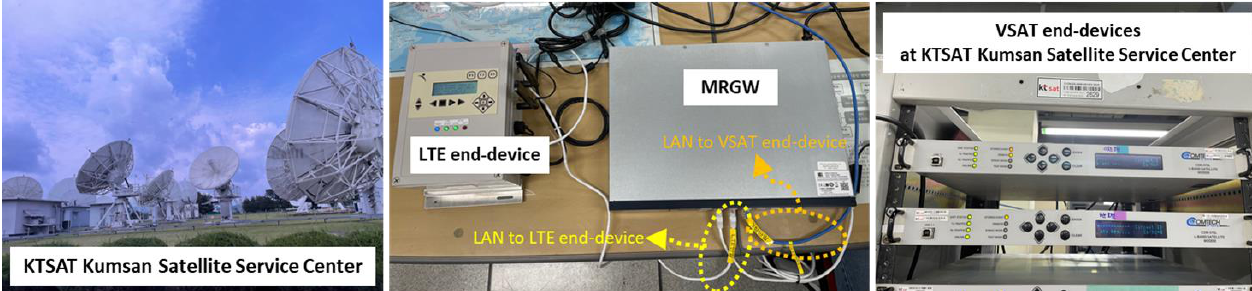
Figure 8. Experimental environment of MRGW interworking between LTE end-device and VSAT end-device at the KTSAT Kumsan satellite service center, in Kumsan, Republic of Korea.